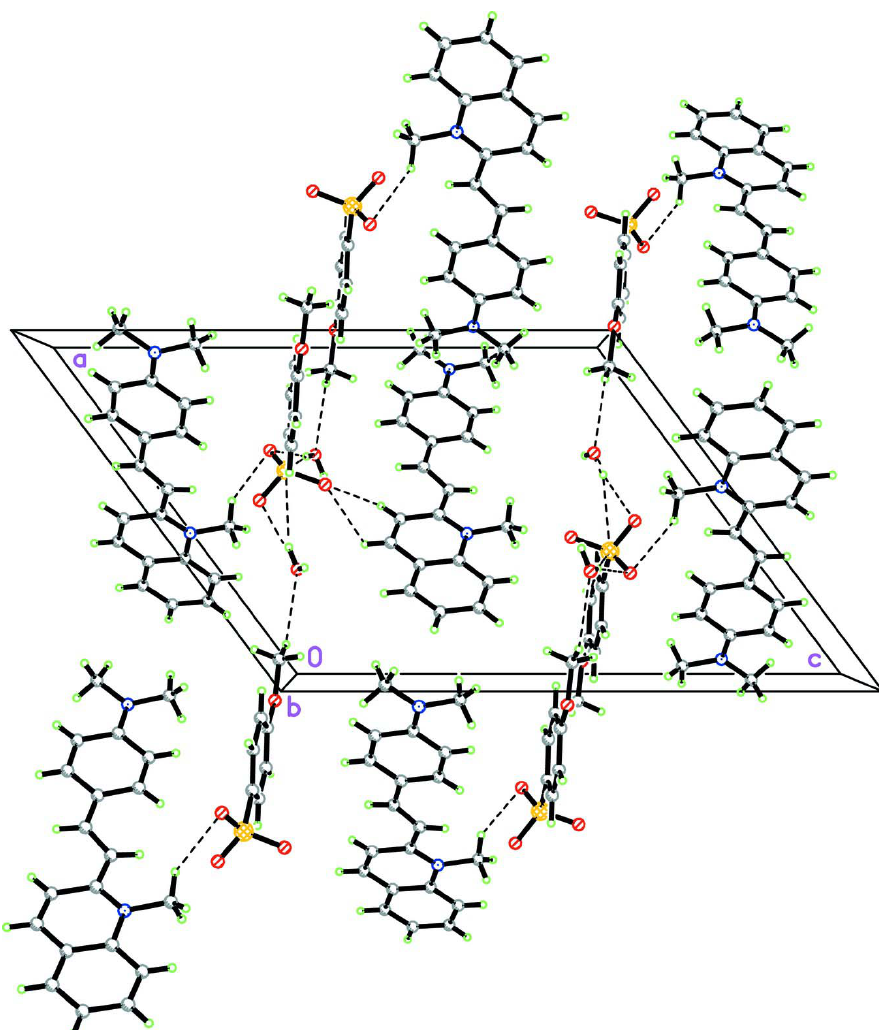
Figure 2 The crystal packing of (I) viewed along the b axis. The O—H···O and weak C—H···O interactions are drawn as dashed